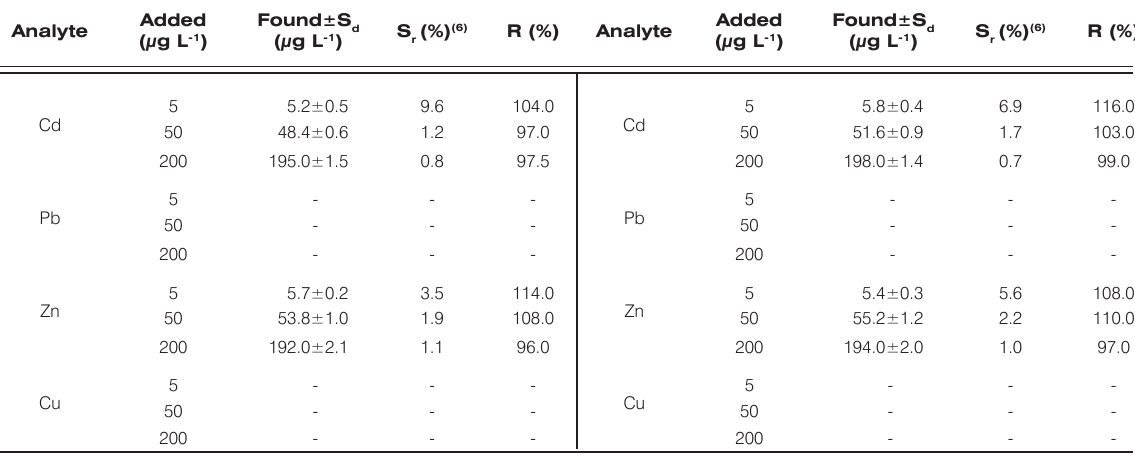
For zinc determination using either electrode the sample and buffer were mixed in a 1:20 ratio prior to analysis to bring the zinc concentration within the linear range. In the cadmium determination samples were not diluted.